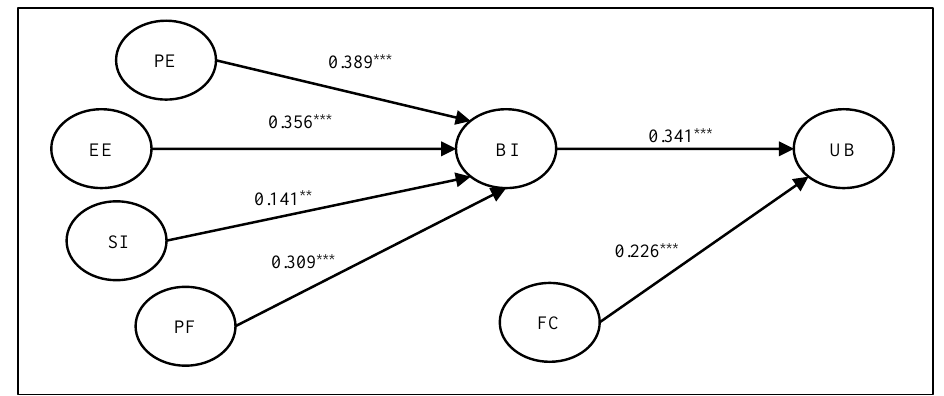
Figure 2. SEM results. Notes: * p < 0.05; ** p < 0.01; *** p < 0.001. Fit indices: Chi-square = 545.112; df = 283; CMIN/df = 1.926; GFI =